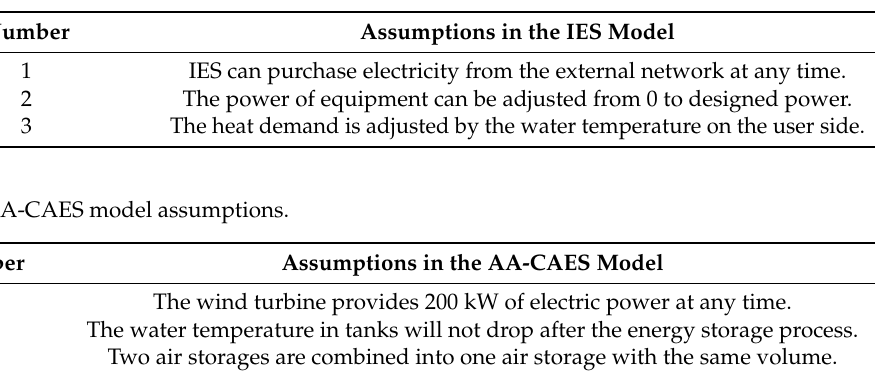
Table 3. IES model assumptions.